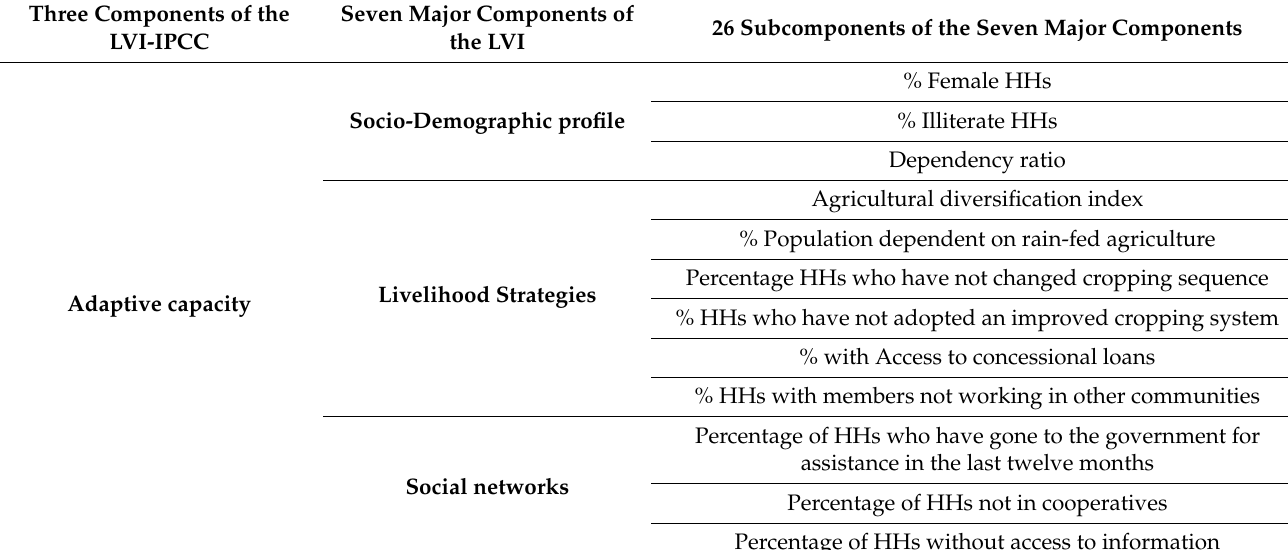
Table A1. A structured questionnaire was developed based on information provided in Appendix A. Our questionnaire had two sections showing the demographic characteristics and a section with indicator